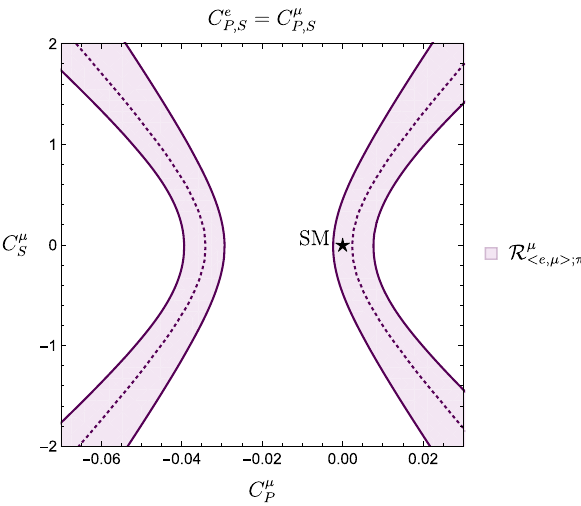
μ μ – C planeobtainedfromtheleptonicover P S μ (cid:3) e ,μ (cid:4);